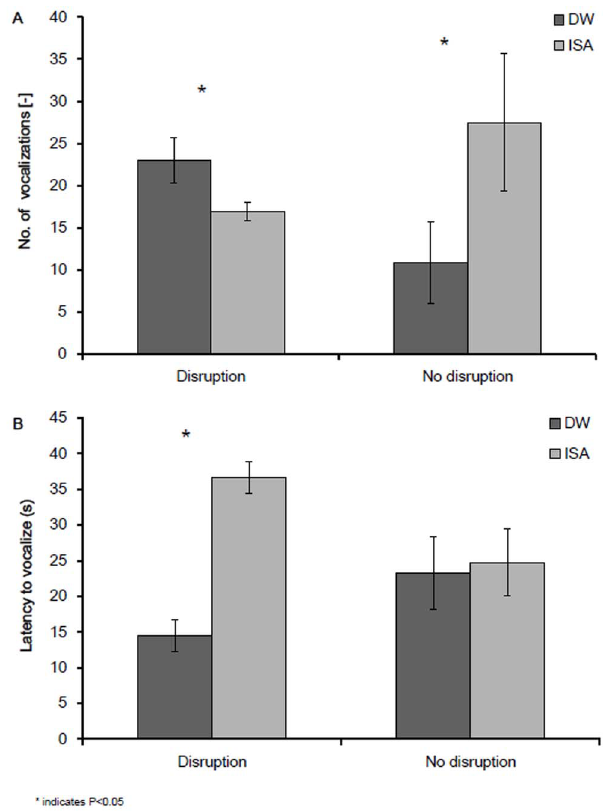
Figure 6. A. Number of vocalizations upon social isolation at 5 weeks of age in Dekalb White (DW) and ISA Brown (ISA) chicks in relation to litter disruption B. Latency to vocalize upon social isolation at 5 weeks of age in Dekalb White (DW) and ISA Brown (ISA) chicks in relation to litter disruption.